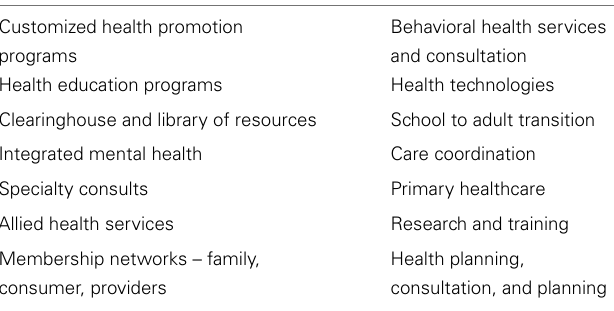
Table 1 | Healthcare programs and services